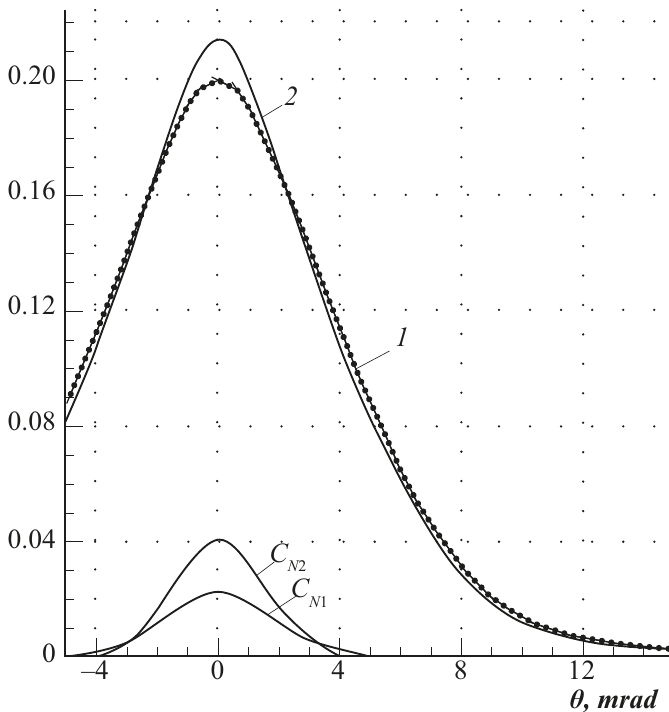
Figure 6. Angular correlation curves of annihilation scattering in cellulose acetate samples (degree of substitution 1.21): at р / р s 1—0.2, 2—0.7.